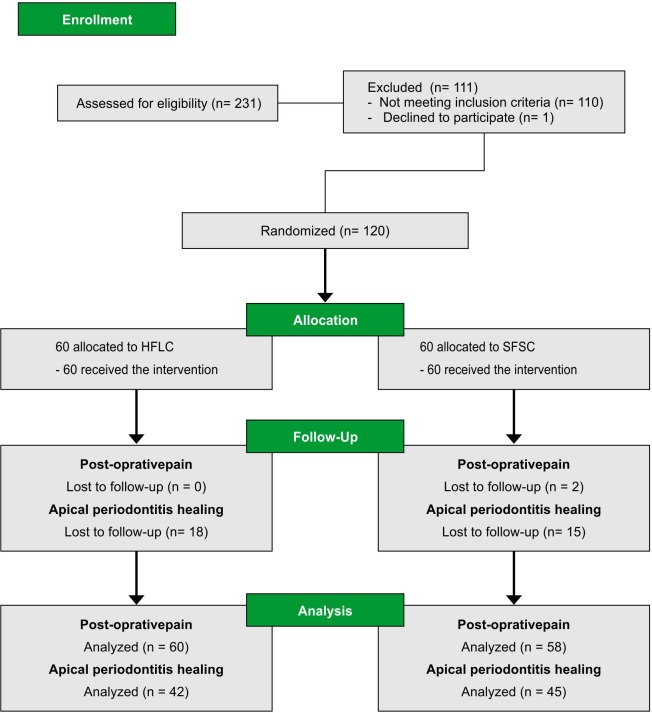
Flow chart diagram.HFLC–Hand-file and lateral compaction. SFSC–Single-file and single-cone.